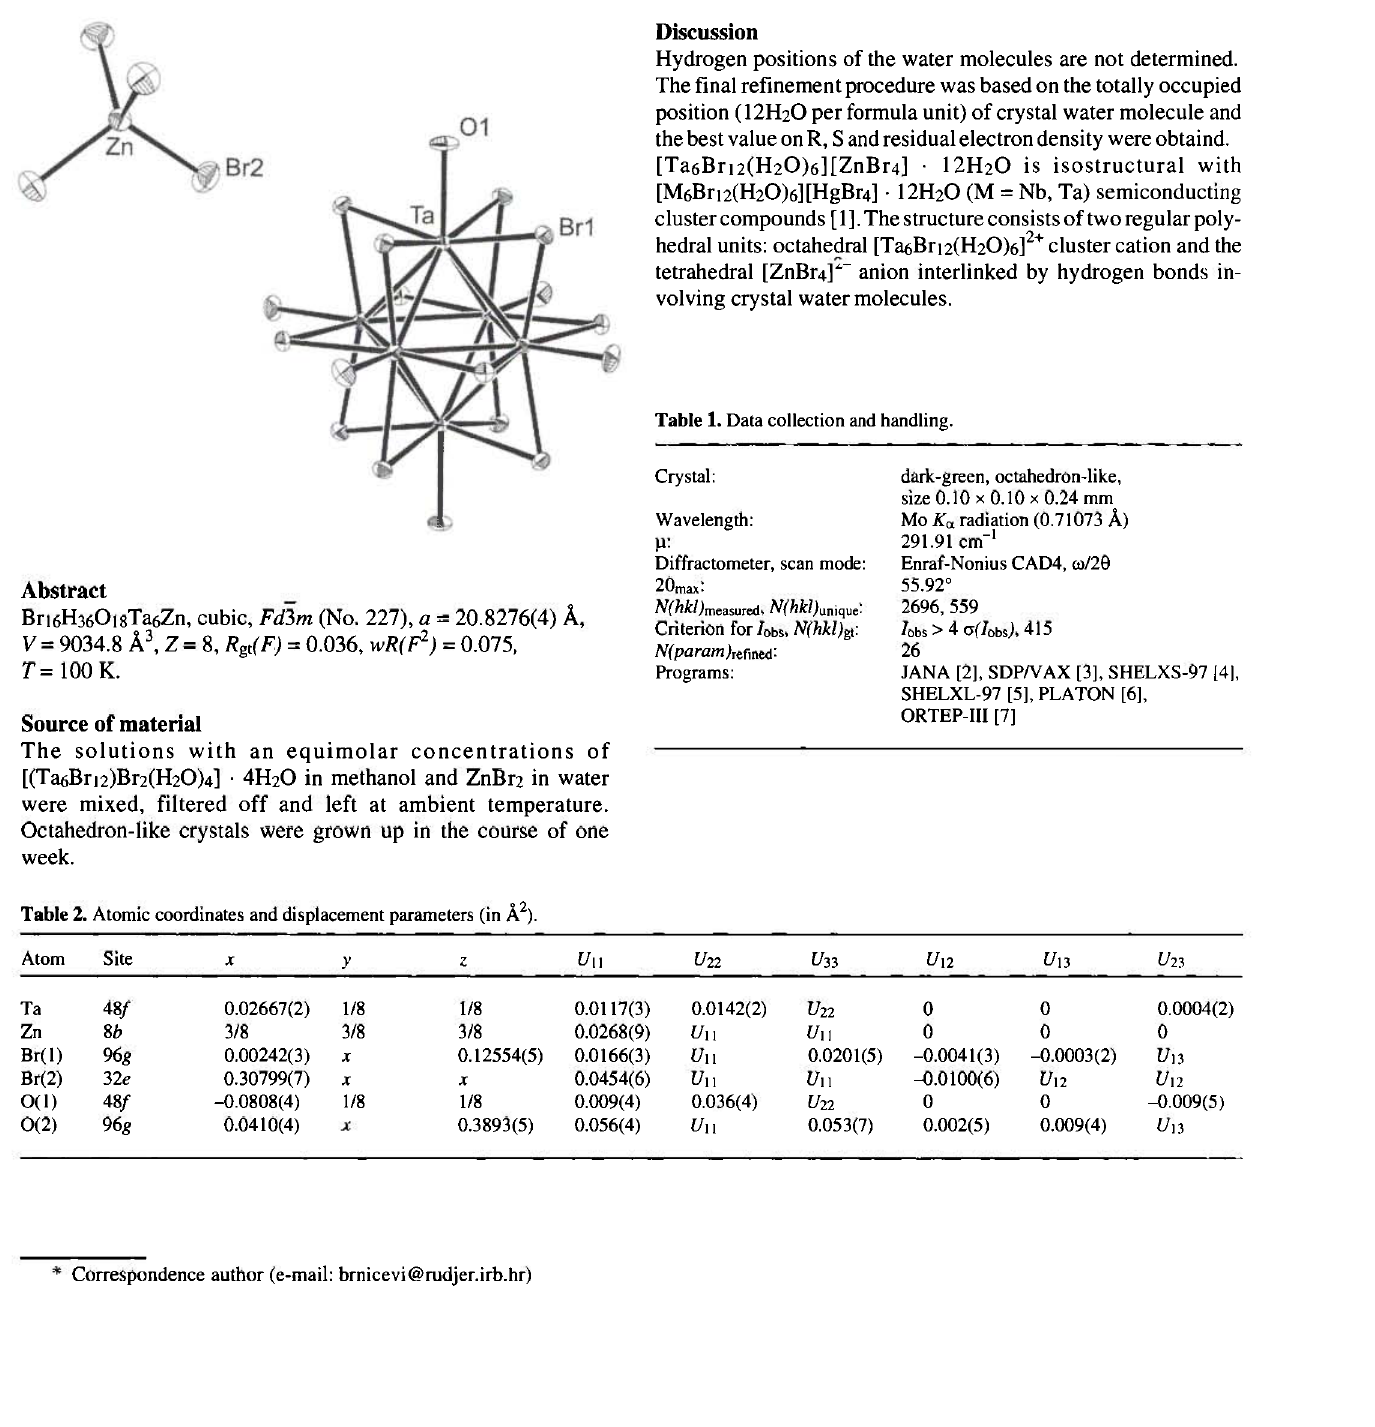
volving crystal water molecules.